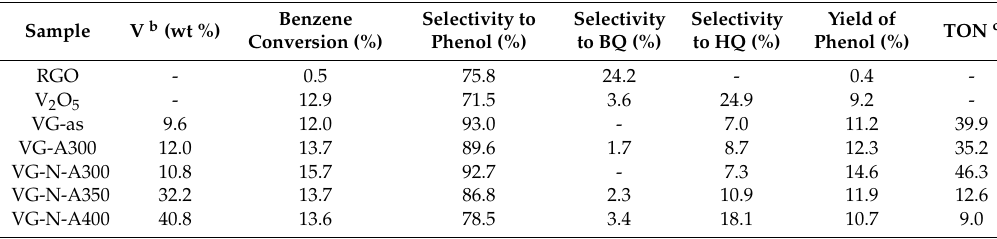
Table 1. The hydroxylation of benzene to phenol over various catalysts a